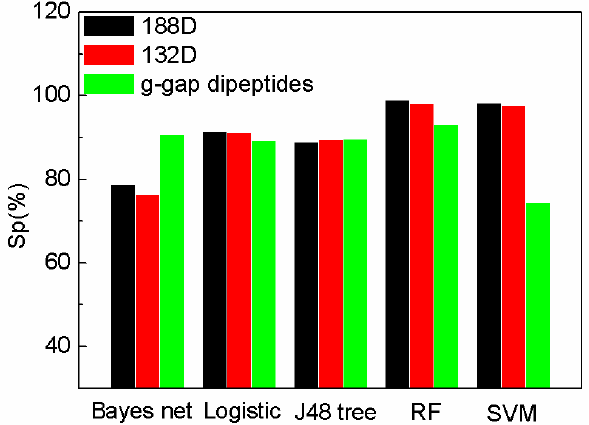
Figure 2. Comparison of our features with g-gap using different classifiers on Sp.